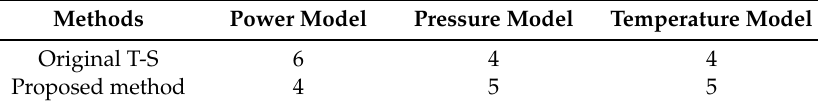
Table 4. Number of rules.